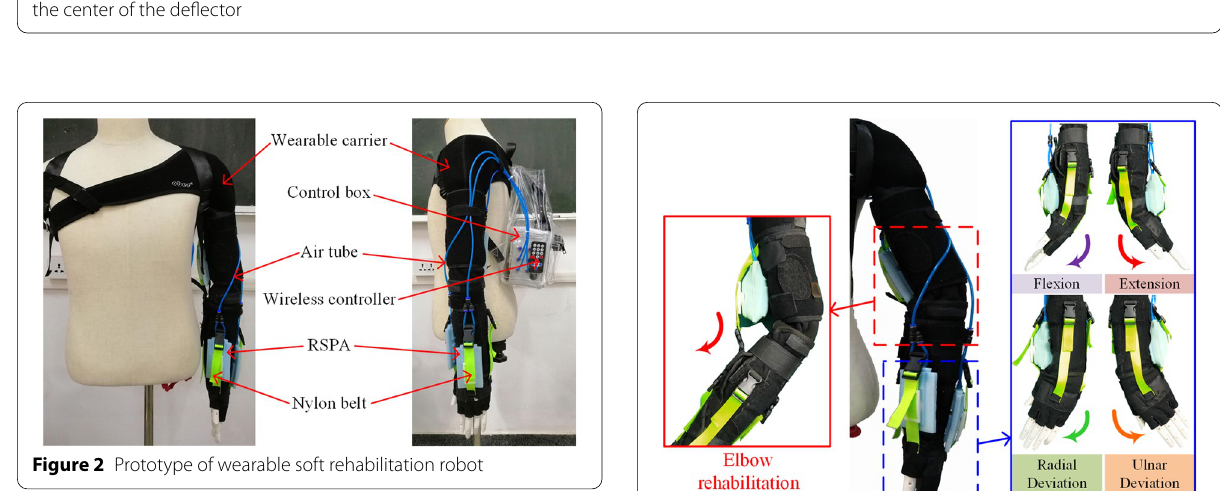
to arrange four RSPAs around the wrist joint to drive the wrist to perform rehabilitation movements, as shown in Figure 3. The control system module in the SWULRR is arranged in a control box designed based on the prin-